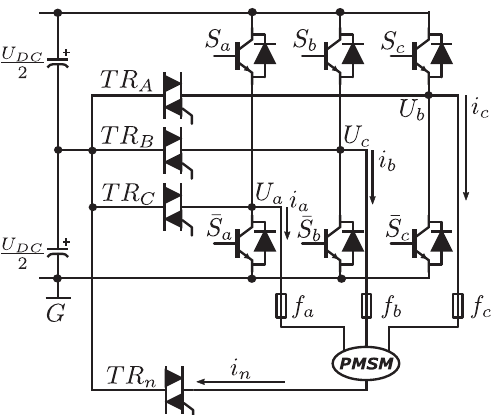
Figure 8. Six-switch inverter for PMSM direct torque control. If the OBC faults a phase, the converter is reconfigured to a four-switch inverter by the respective TRIAC ( TR A , TR B , or TR C ).